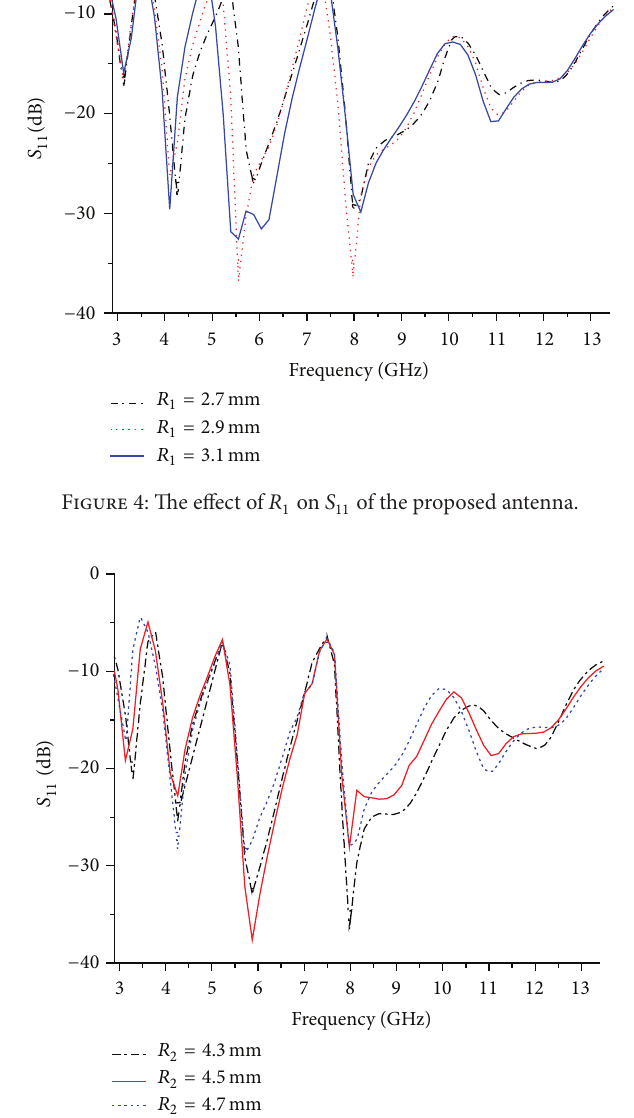
Figure 5: The effect of 𝑅 2 on 𝑆 11 of the proposed